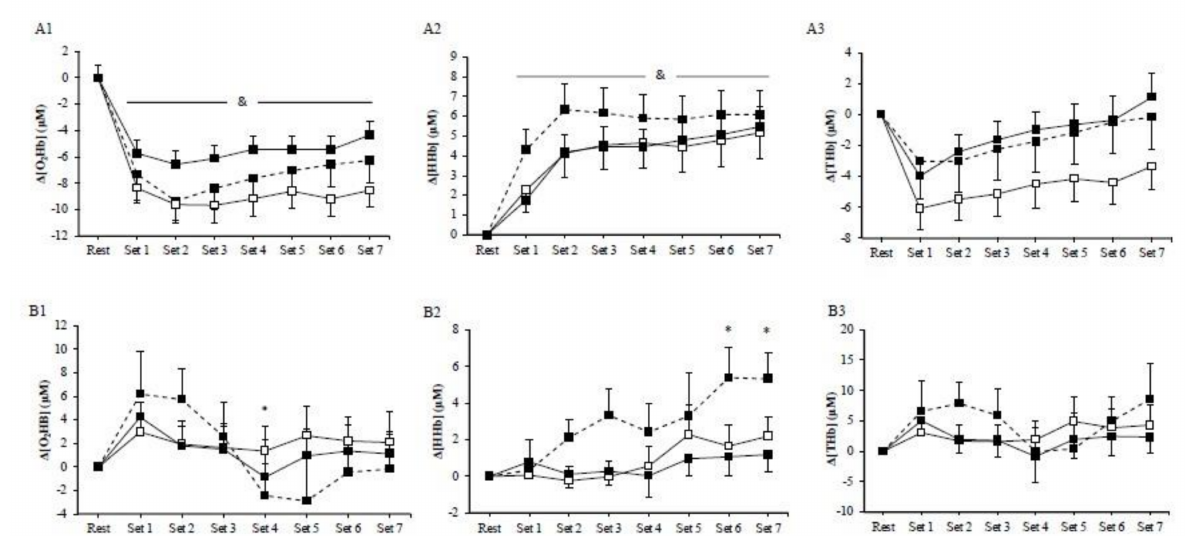
Figure 2. Muscle ( A ) and cerebral ( B ) oxyhemoglobin (1), deoxyhemoglobin (2), and total hemoglobin (3) during the cycling (dash line), the concentric ( (cid:3) ), and the eccentric ( (cid:4) ) exercise. (*) indicates significant difference compared to baseline in the cycling exercise; (&) indicates significant difference compared to baseline for all exercise modes.